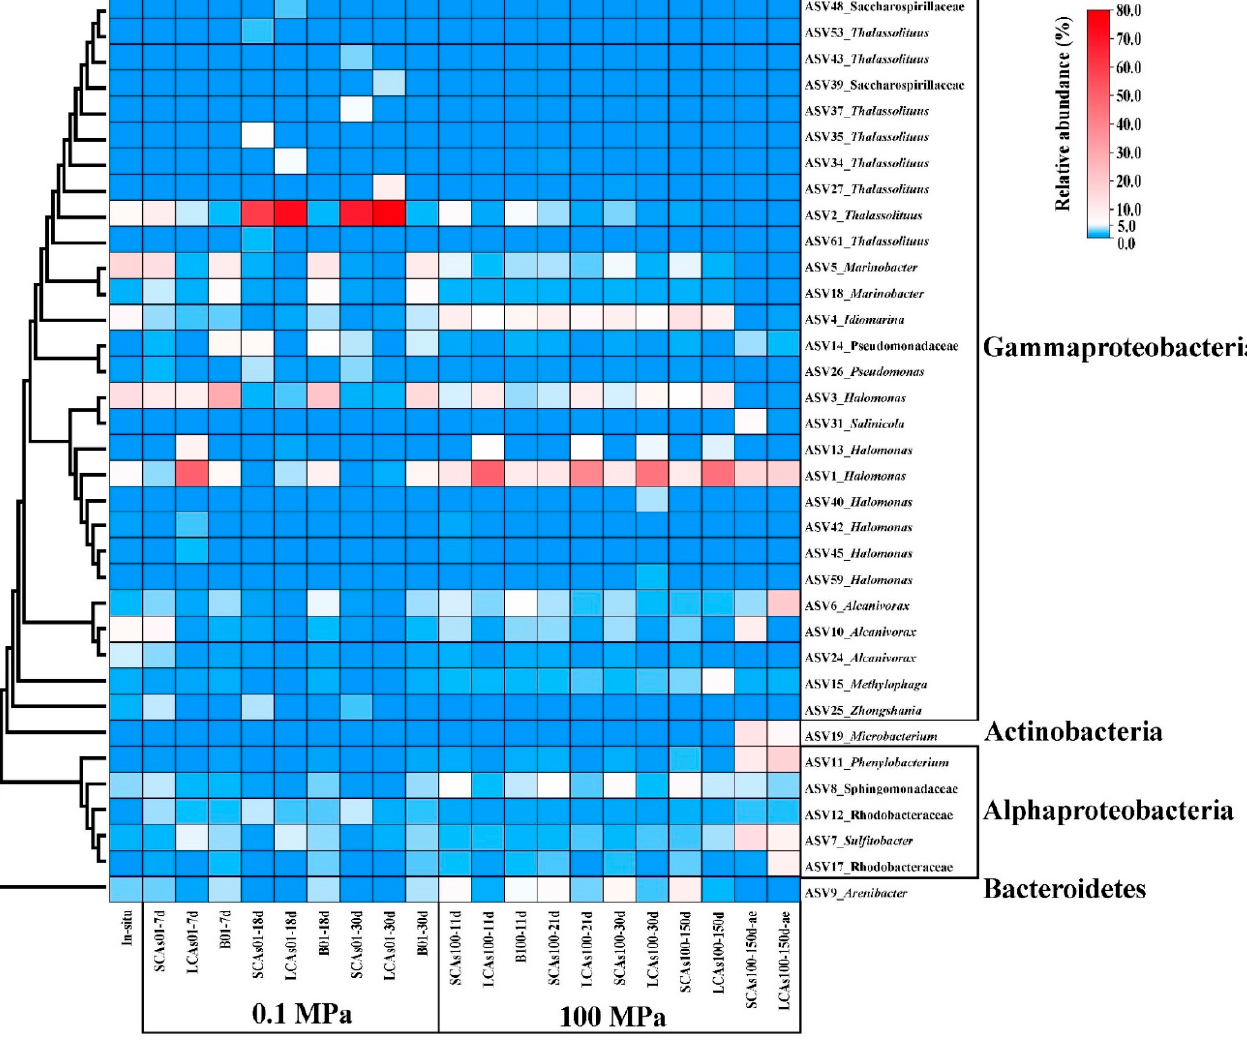
Figure 5. The phylogenetic tree of the 35 most abundant ASVs and 16 genera and the corresponding relative abundance are listed in the heatmap at the right.